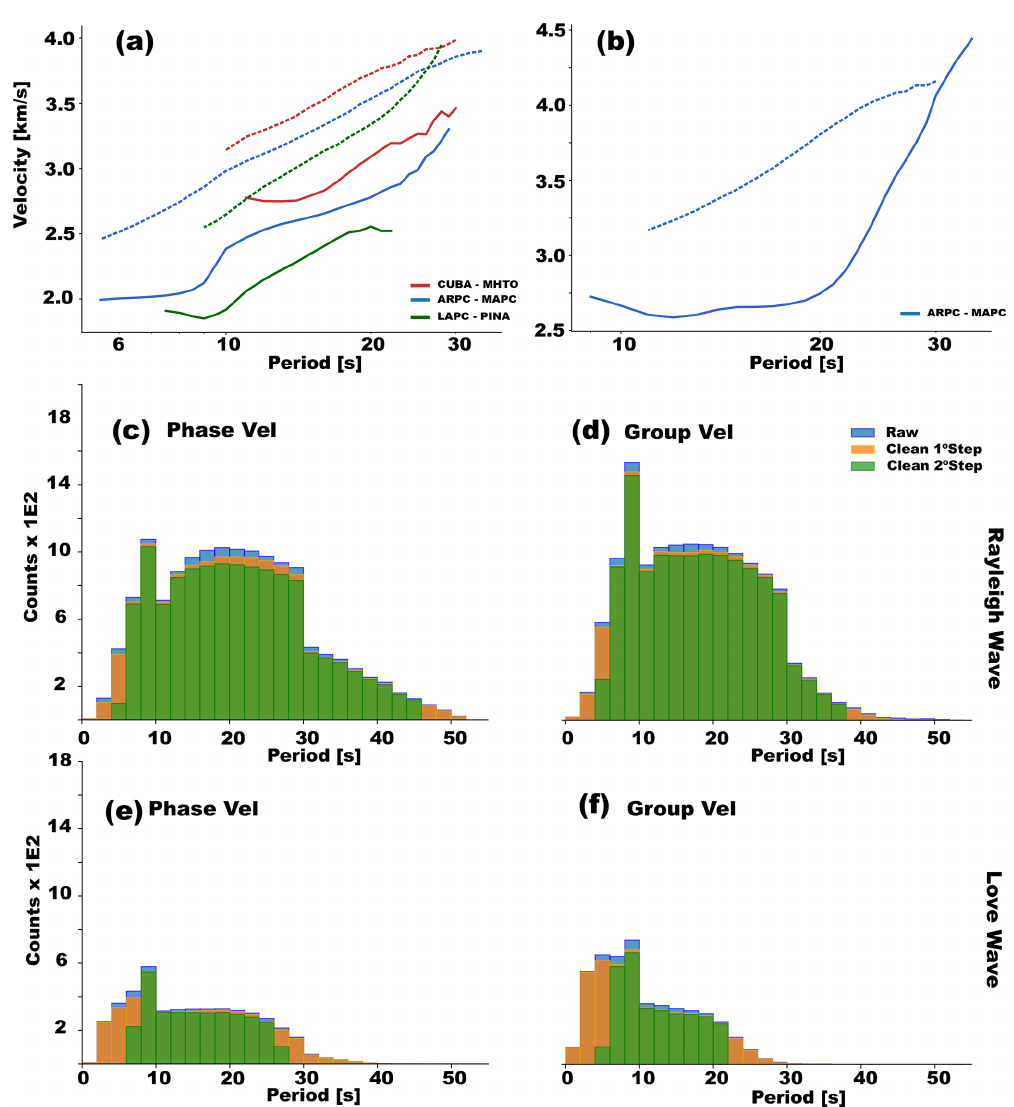
Figure 4. Dispersion curves for multiple EGFs and station pair waveforms corresponding to those shown in Fig. 2 (see Fig. 1 for station locations). (a) Rayleigh-wave dispersion curves for phase velocity (dashed lines) and group velocity (solid lines). (b) Love-wave dispersion curves for phase velocity (dashed lines) and group velocity (solid lines). Note that only land–land stations are viable for Love-wave dispersion analysis. (c, e) Phase velocity histograms of dispersion measurements for Rayleigh and Love waves, respectively. (d, f) Love velocity histograms of dispersion measures for Rayleigh and Love waves, respectively. Blue bars correspond to raw measurements, orange bars correspond to measurements obtained after cleaning by smoothing the phase/group dispersion maps ( α = 2000), and green bars are the final measurements obtained after excluding outliers that are outside of 3 standard deviations for a given wave